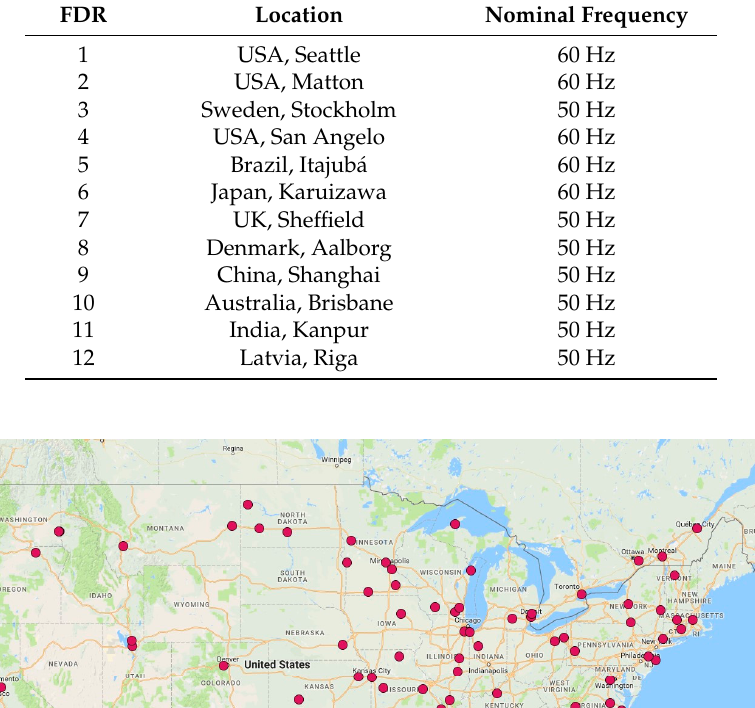
Table 1. Basic information of the selected FDRs in this study. FDR Location